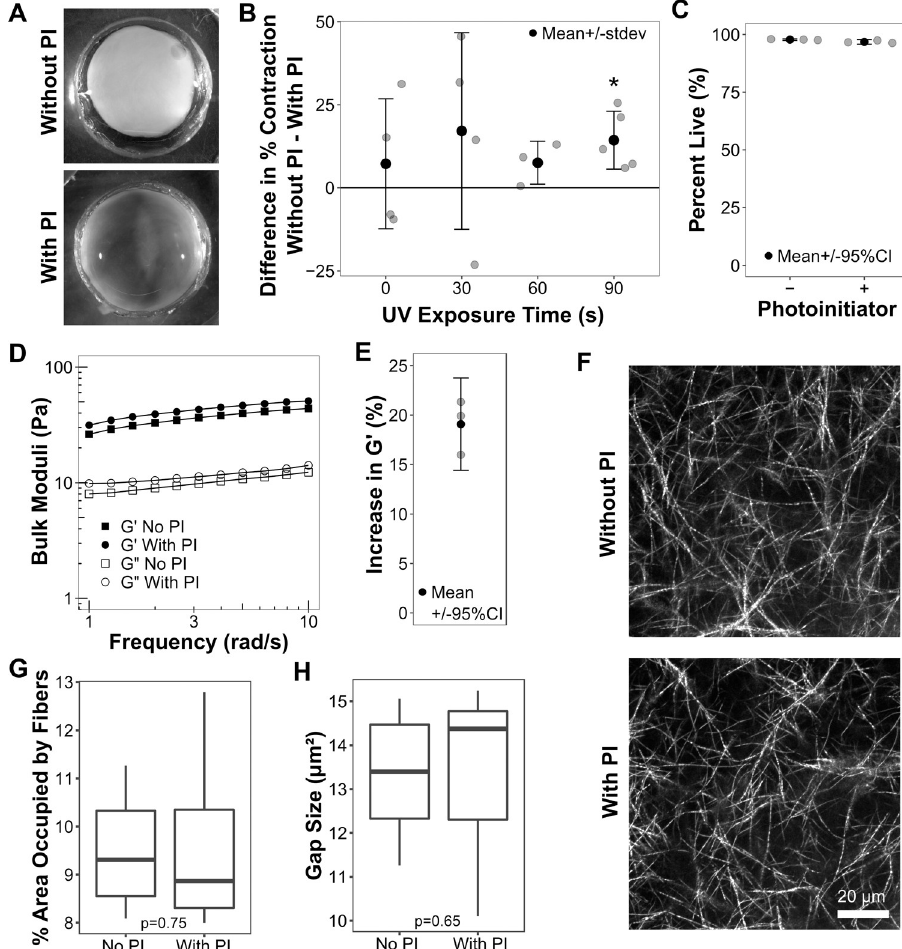
Fig 1. Crosslinking limits the ability of cells to remodel collagen matrices. (A-B) HT-1080 cells were seeded in 2 mg/ml methacrylated type I collagen gels with or without photoinitiator (PI) and then exposed to UV light (325–375 nm, ~7 mW/cm 2 ) for 0, 30, 60 or 90 s. Gels were then released from the sides of the well, cultured for 24 h, and finally imaged with a stereoscope. ( A ) Representative images of gels with and without PI (90 s UV exposure time). The gel without PI is visibly contracted relative to the gel with PI as seen by its smaller area and greater opacity. The well diameters in both images are ~ 1 cm. ( B ) Plot of the difference in percent contraction (area) between paired gels with and without photoinitiator (mean +/- stdev). Each point corresponds to a pair of native and crosslinked gels from the same experiment and with identical UV exposure times (left to right, n = 4, 4, 3, and 5 pairs). The only exposure time to yield a significant difference between gels with and without PI was 90 s (p = 0.021, one-sample, two-tailed t-Test). ( C ) Cells were seeded in matrices with and without PI, exposed to UV light for 90 s, incubated 2 h, and then stained with Calcein AM and propidium iodide. Cells exhibiting Calcein staining were classified as “live”; cells exhibiting propidium iodide staining were classified as “dead.” The gray points show the percent of live cells in each experiment; the black points show the mean +/- the 95% confidence interval for each sample type. There was no significant difference between matrices without (“-”) and with (“+”) PI (p = 0.08; t-Test; n = 3 experiments, each with > 200 cells counted).( D ) Representative rheological data from shear modulus frequency sweep measurements of paired cell-free gels with (circles) and without (squares) PI (90s UV exposure time; 2 h incubation). Storage moduli (G’, black points) and loss moduli (G”, open points) are plotted on log-log axes. The gel with PI had higher storage moduli than the gel without PI at all measured frequencies. ( E ) Gels with PI exhibited higher storage moduli (G’) than their paired native gels in three separate experiments. The percent increase in G’ (with PI—without PI) is plotted for each experiment (gray points) along with the mean (black point) and the 95% confidence interval. The confidence interval does not include 0, demonstrating that the difference in storage moduli is statistically significant. (F-H) Cell-free gels with and without PI (90s UV exposure time; 1.5 h incubation) were imaged in confocal reflectance mode. ( F ) Representative maximum-intensity z-projections from seven independent gels (for each treatment). ( G ) Average fiber-occupied area expressed as a percent of the total field-of-view area. ( H ) Average gap (pore) size. There were no statistically significant differences in fiber density or pore size between gels with and without PI (Kruskal-Wallis test; n = 7,